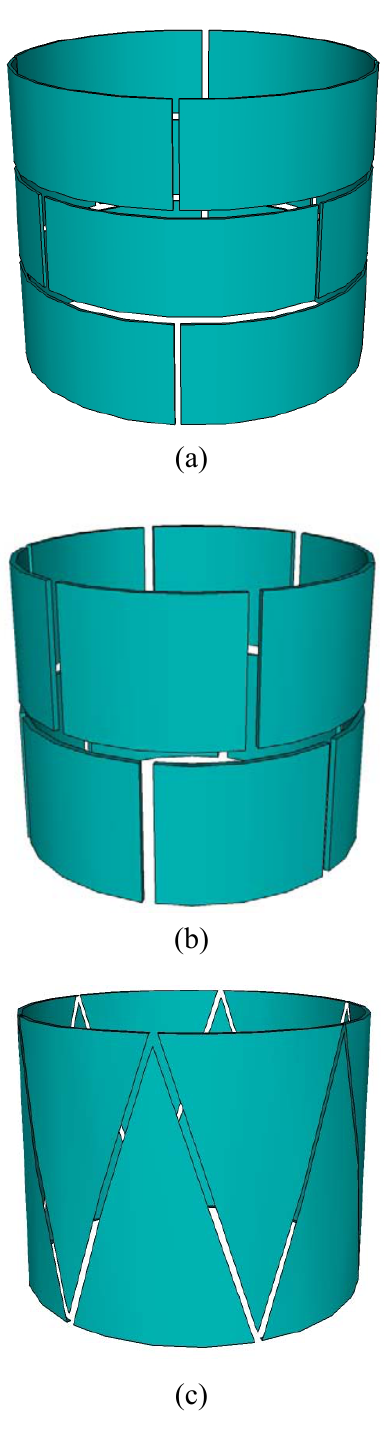
Figure 3. Configuration of ECVT sensor: (a) three-layer sensor; (b) two-layer sensor; (c) single-layer